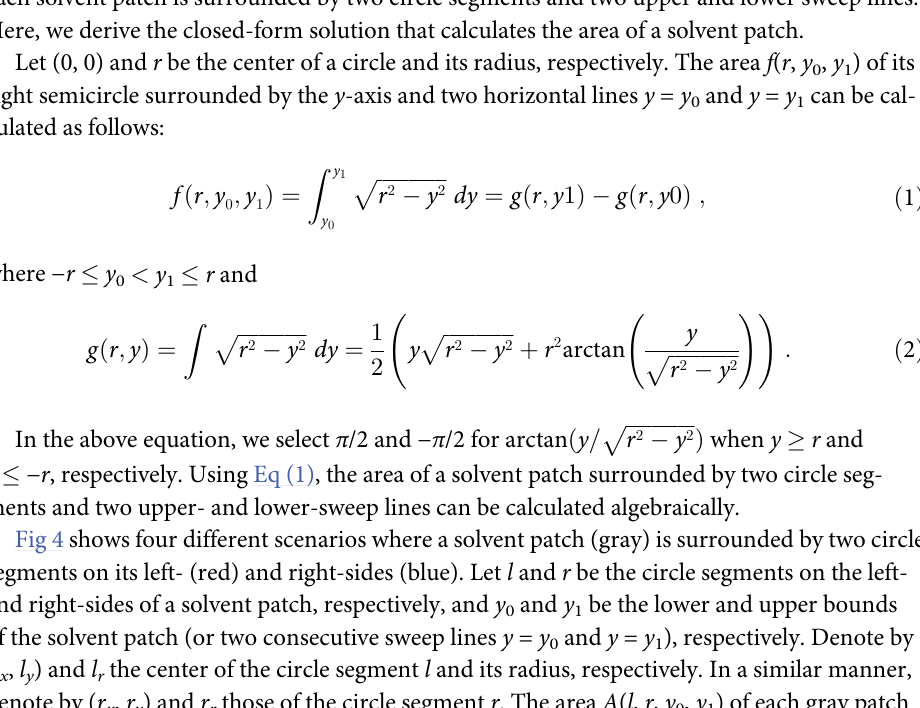
and e . Lines 3–4 determine the upper y i − 1 i